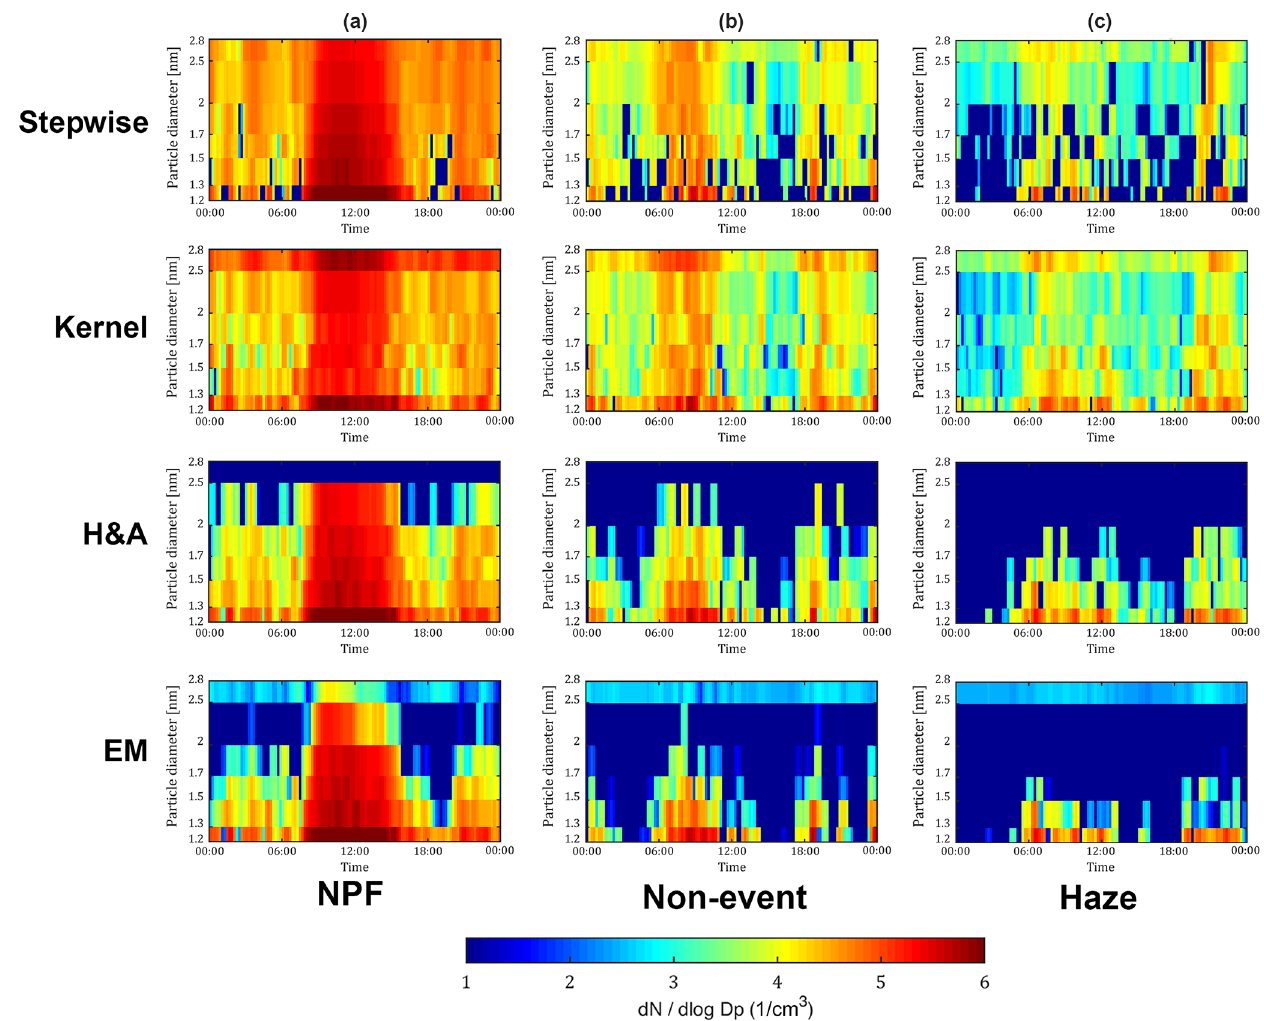
Figure 4. The stepwise, kernel, H&A and EM inversions of (a) a selected NPF event on 30 January 2018, (b) a non-event on 6 March 2018 and (c) a haze event on 9 March